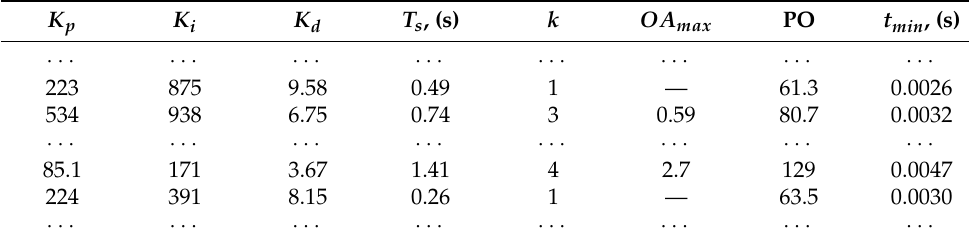
Table 4. Step-response characteristics provided by the tuning algorithm. The value of OA max provides us with the scale of oscillations. If the number of local extremums k ≤ 1, then this value is obviously not